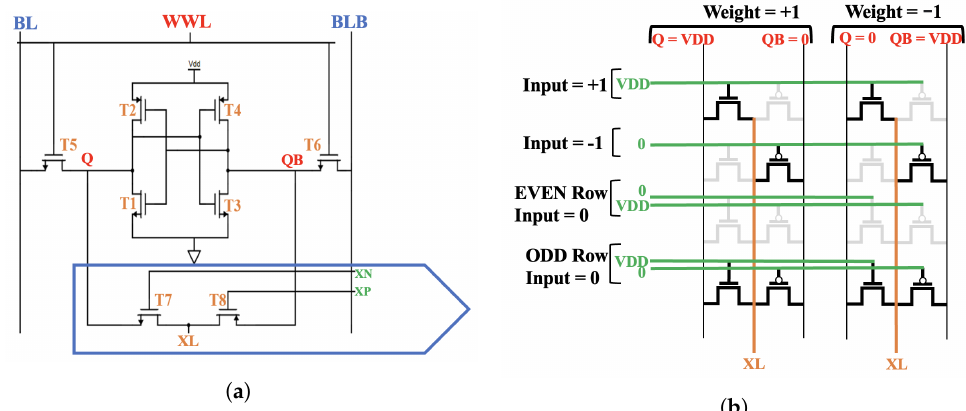
Figure 3. ( a ) Proposed 8T XNOR-SRAM Bitcell ( b ) Transistor Behavior of the XNOR